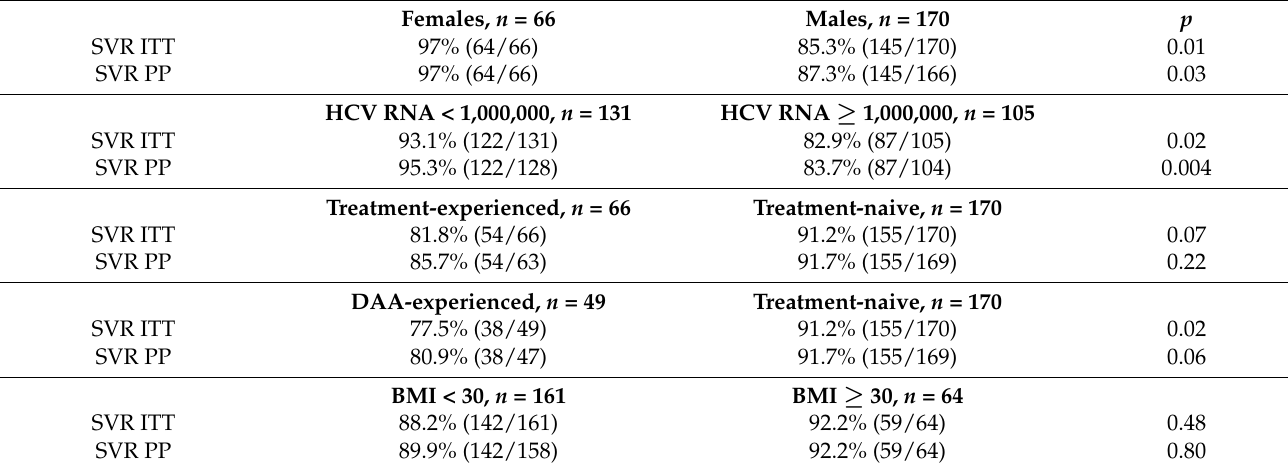
Table 7. Treatment effectiveness in subpopulations.